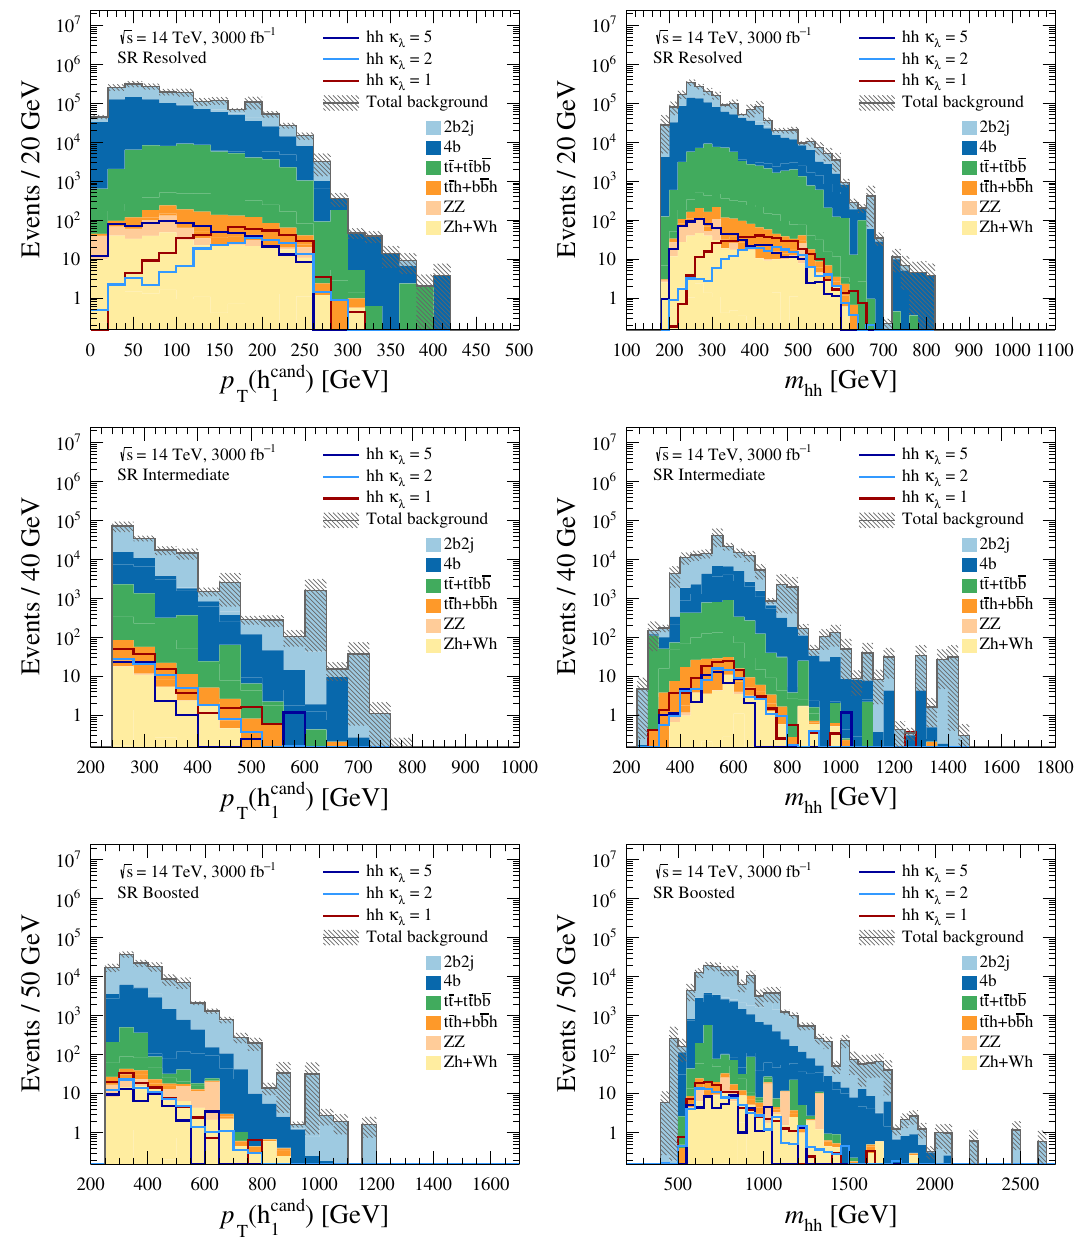
Figure 7. The baseline analysis leading Higgs candidate transverse momentum p T ( h 1 ) (left) and invariant mass of the pair of Higgs boson candidates m hh (right), for benchmark signals (lines) and background (filled). These are displayed for resolved (upper), intermediate (middle) and boosted (lower) categories after all kinematic selections, including m ( h i ) mass window cuts, are